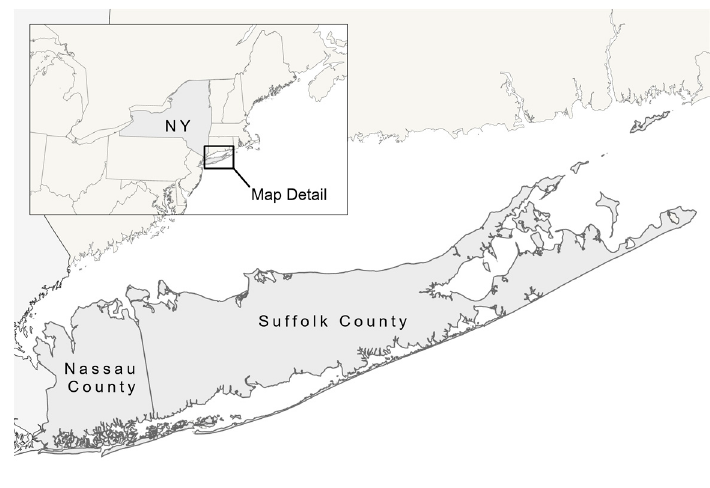
Figure 1. Survey Study